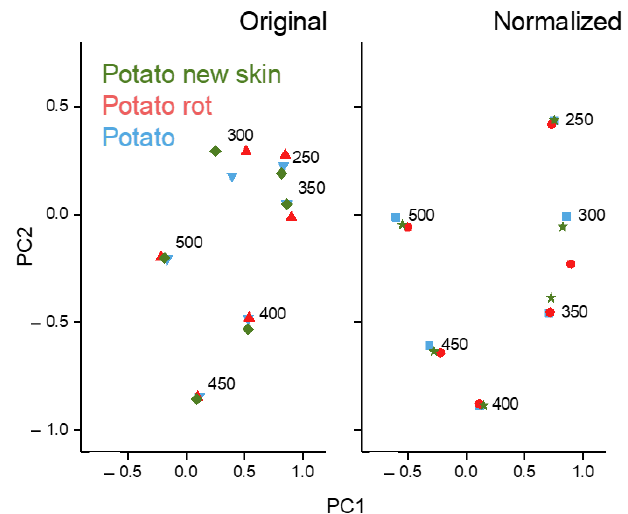
Figure 7. Results of principal component analysis of original ( left ) and normalized ( right ) data for the surface of the Kumach, Udacha, and Zhukovsky variety (blue), during rotting (red), mechanical damage spot with new skin (green).